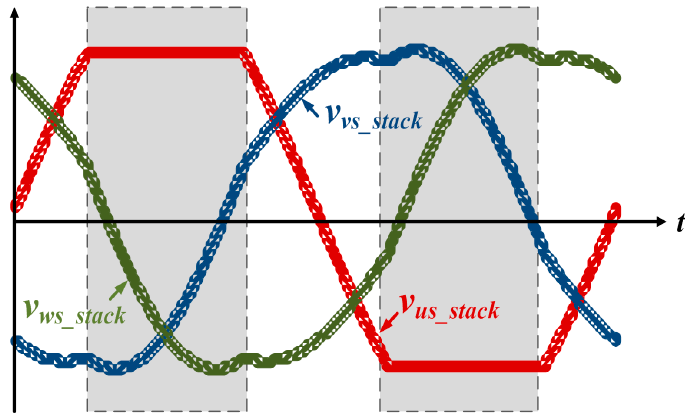
Figure 8. The individual stack reference voltage of proposed neutral-point voltage-shifting control.